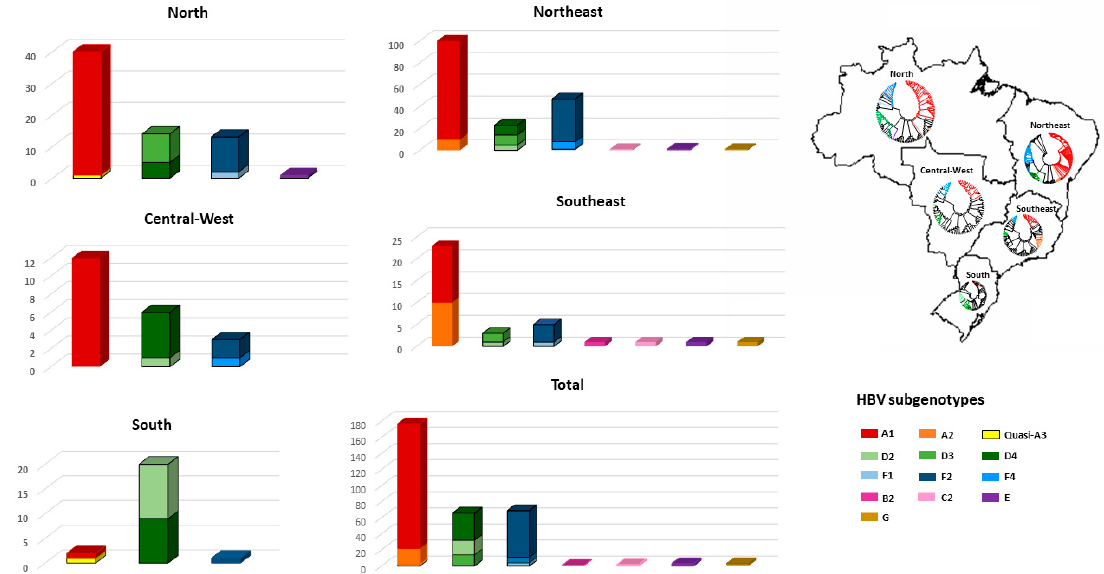
Figure 3. Distribution of HBV genotypes according to geographic regions. The phylogenetic trees in Brazilian map reflects the HBV subgenotypic diversity in each region. Taxa represented in black are reference sequences retrieved from Genbank.